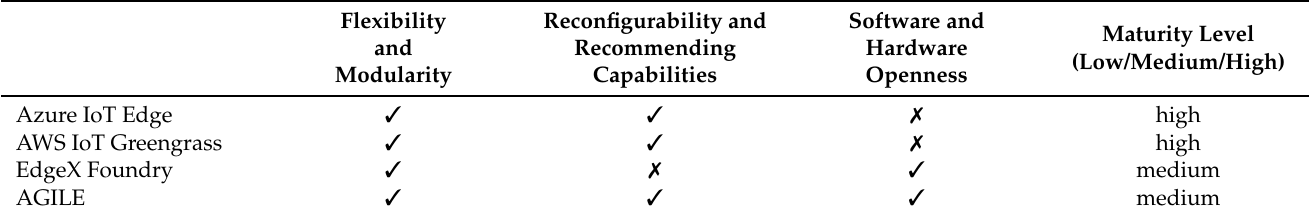
Table 1. A visual comparison of the most mature edge computing solutions in terms of their flexibility, reconfigurability, openness, and maturity